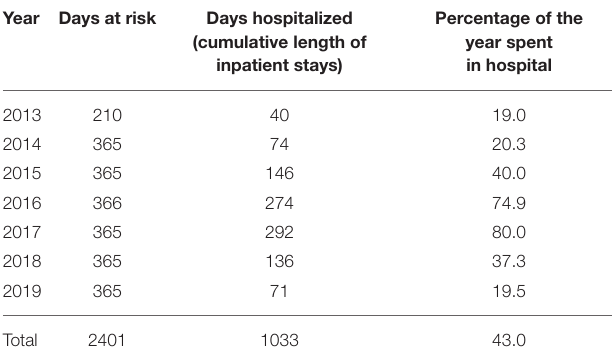
TABLE 4 | Cumulative duration of hospitalization